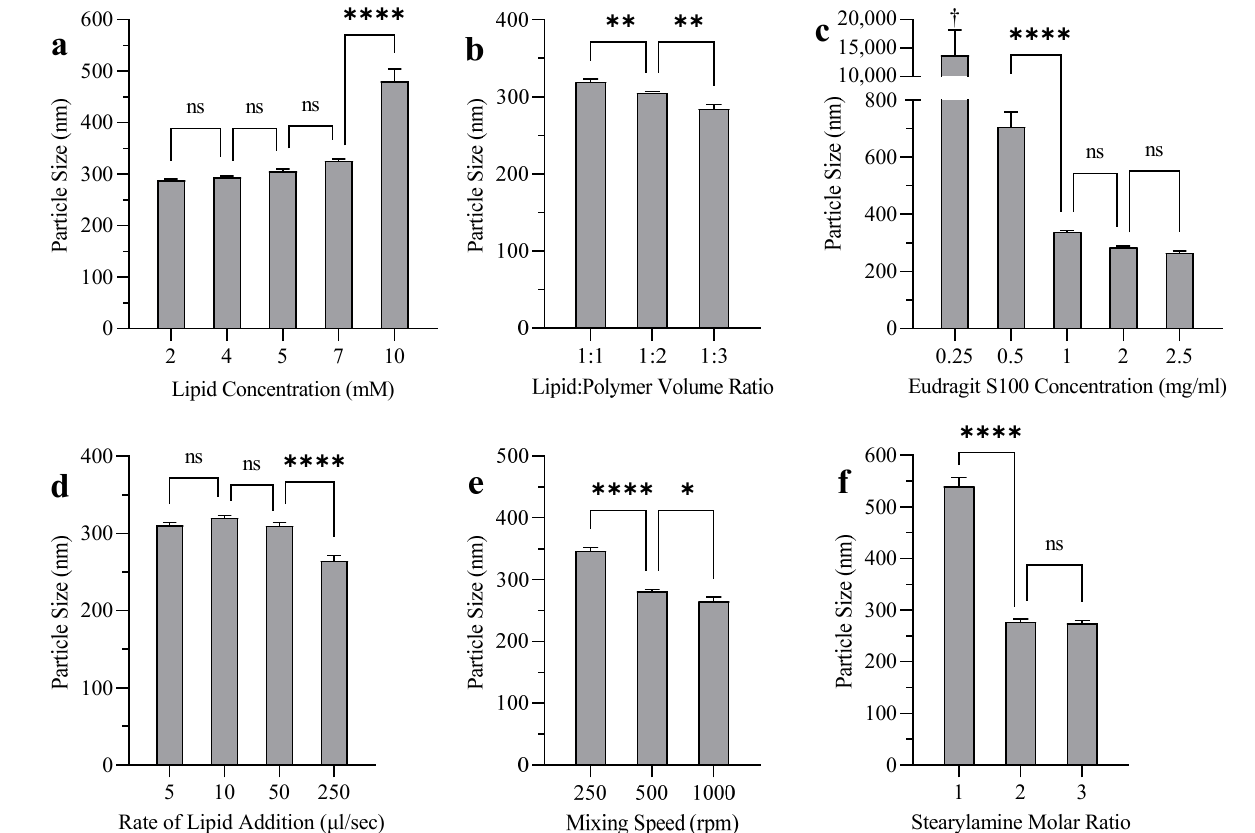
Figure 4. The effect of various coating variables: ( a ) lipid concentration, ( b ) lipid–polymer volume ratio, ( c ) ES100 concentration, ( d ) rate of lipid addition, ( e ) mixing speed, ( f ) SA molar ratio on the particle size of liposomes. Notes: The data represents the mean ± standard deviation (n = 3). (ns p ≥ 0.05, * p < 0.05, ** p < 0.005, **** p < 0.0001) compared to adjacent formulation(s). †: Results do not meet DLS criteria (not included in one-way